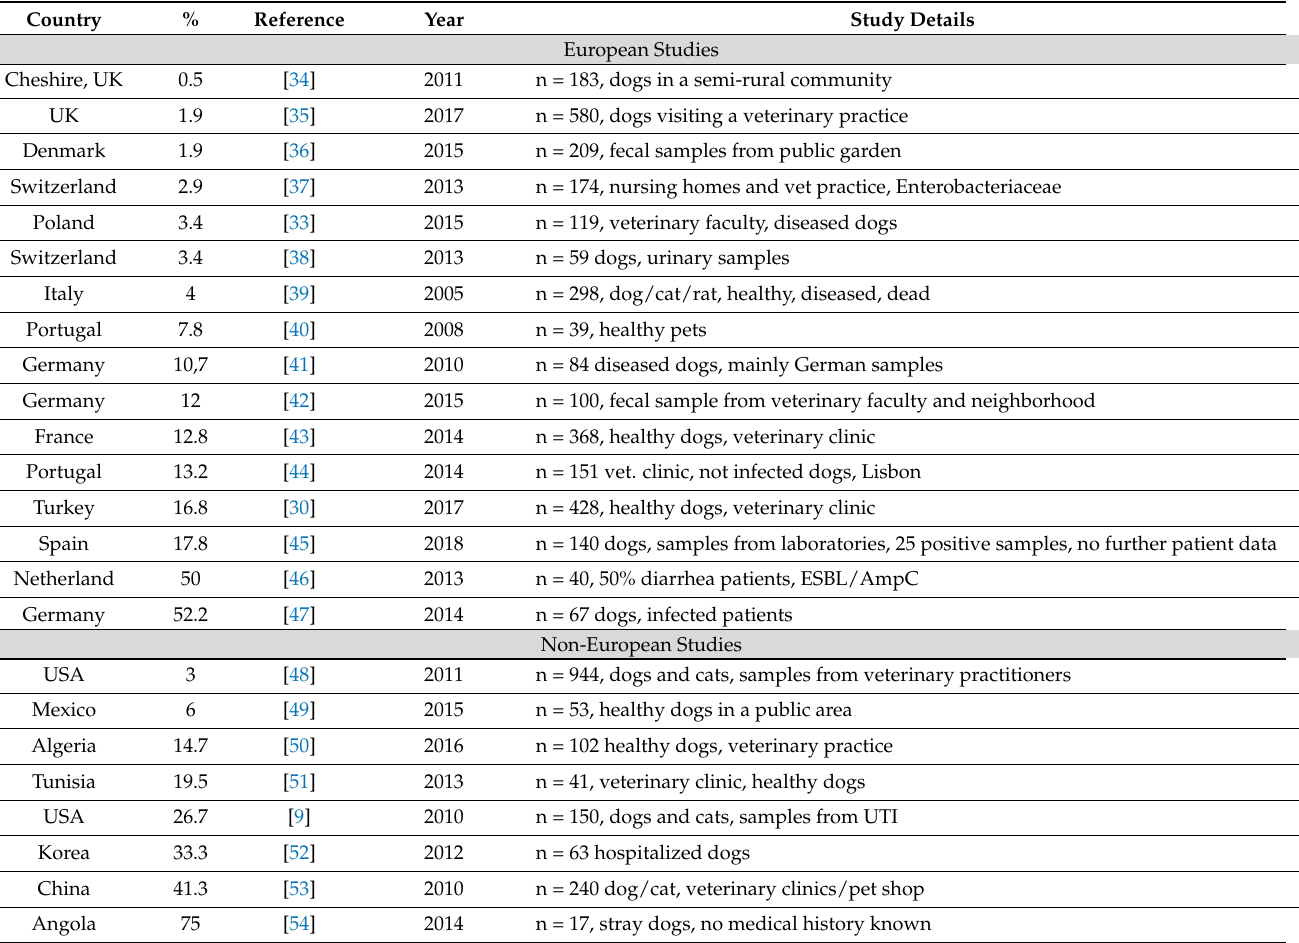
Table 3. Brief summary of recent studies on ESBL-producing E. coli in small